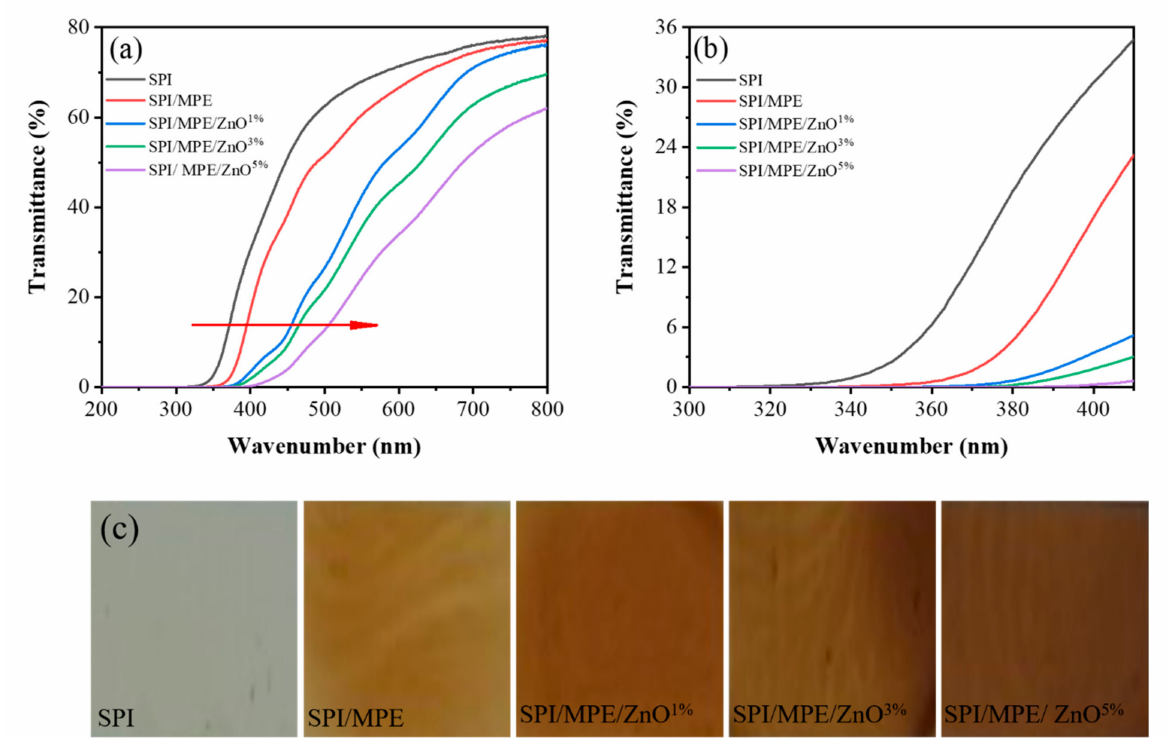
Figure 2. UV-vis light transmittance of SPI films. The red arrows indicate that the UV resistance of the films is significantly improved with the addition of MPE and ZnO NPs, and the increase of ZnO NPs content ( a ). UV-vis light transmittance of SPI films at 320–400 nm ( b ). The physical appearance of SPI films ( c